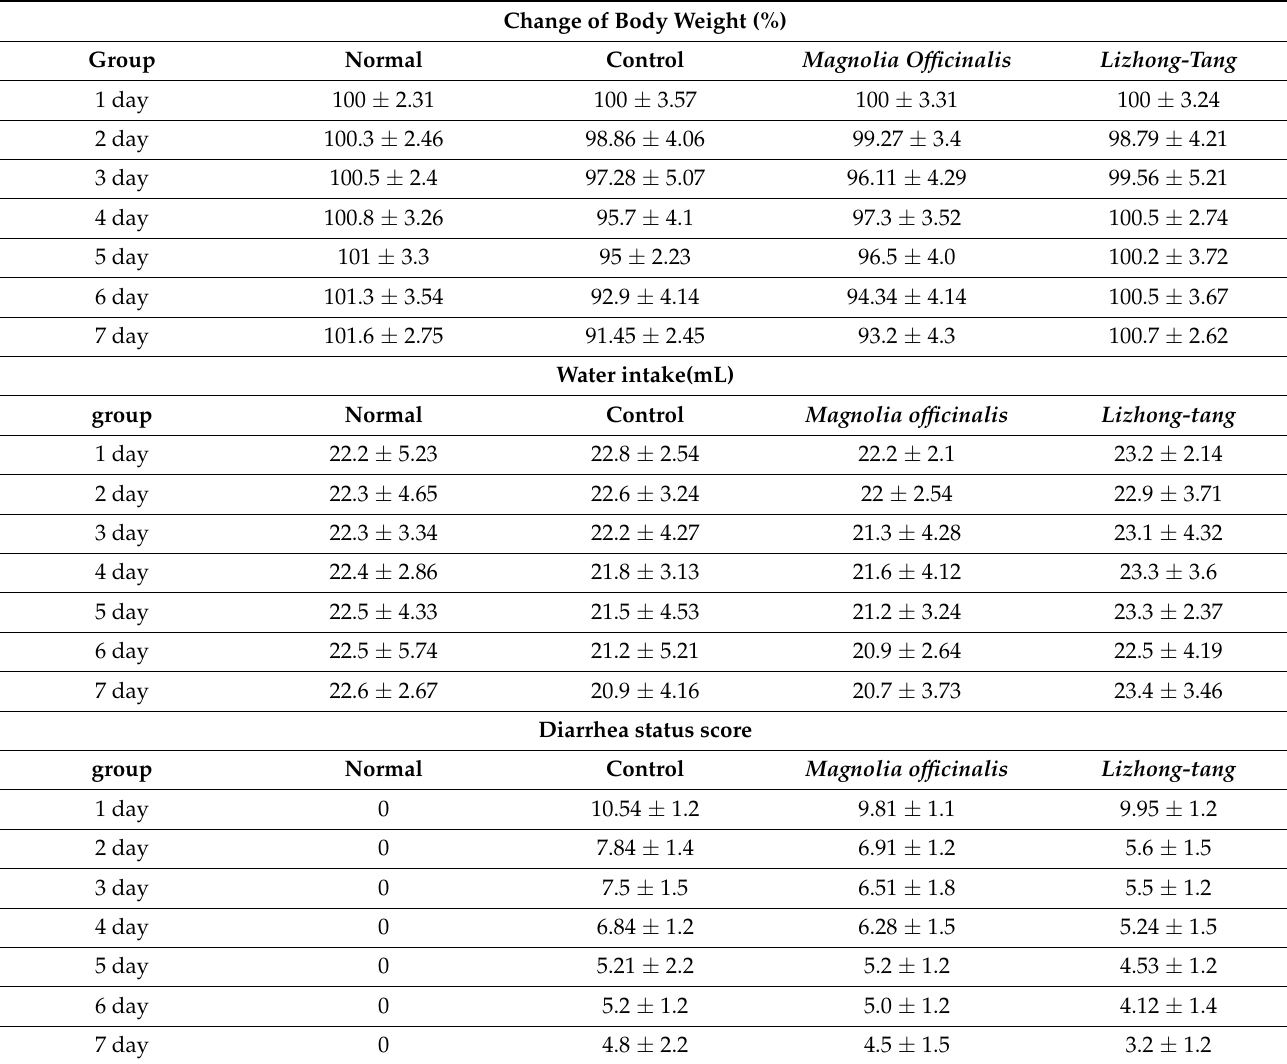
Table 2. Relative abundance of weight, fluid intake, and diarrhea level in each